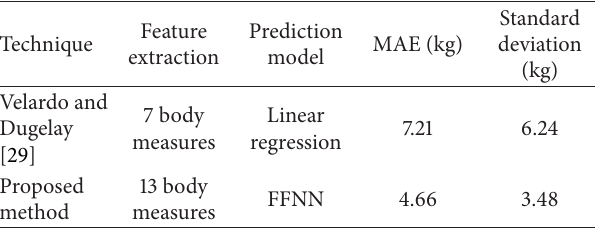
Table 3: Comparison of weight estimation with baseline model. Table 4: Results of weight estimation for unknown